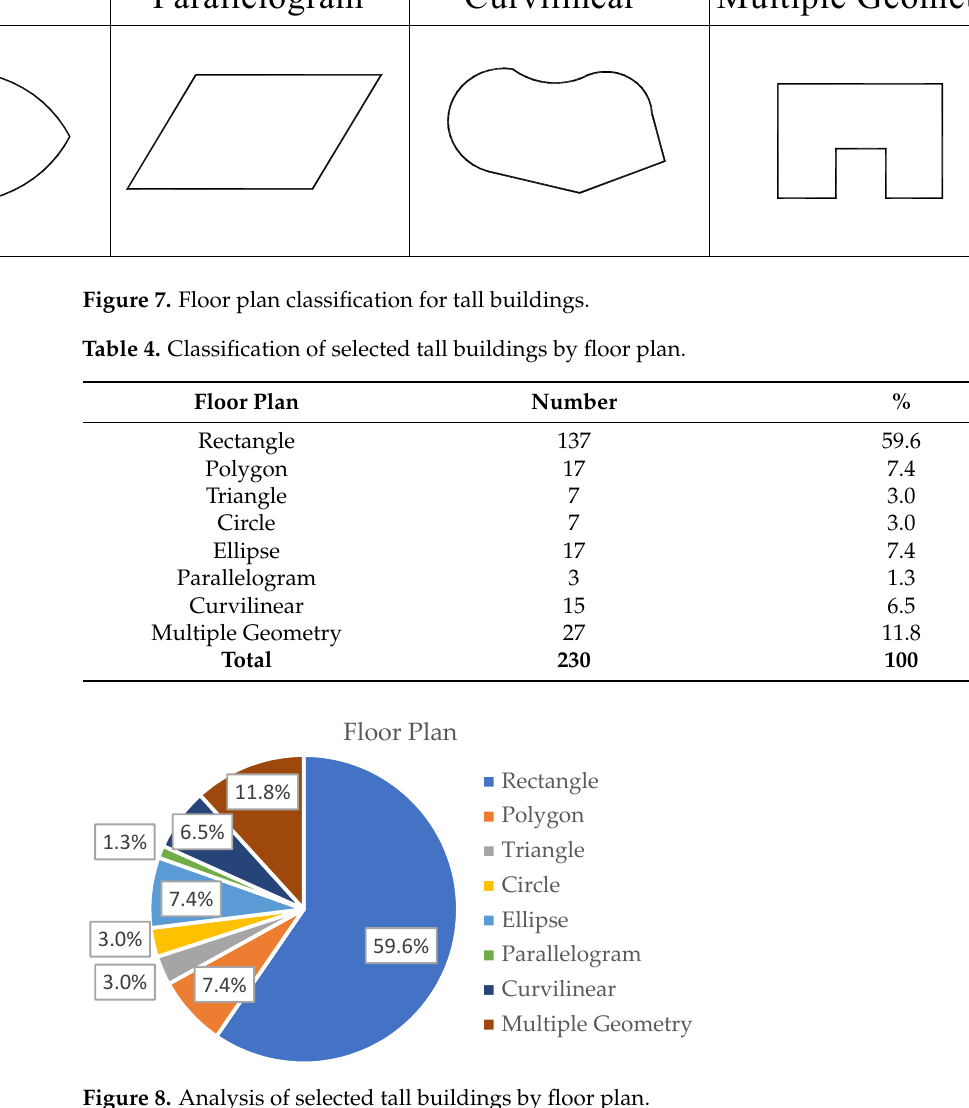
Figure 8. Analysis of selected tall buildings by floor plan.